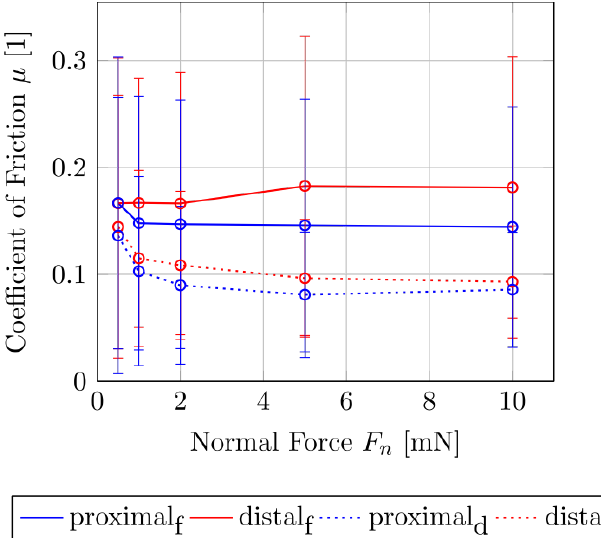
Figure 3. Coefficient of friction for different normal loads calculated from friction force measurements in the tibia–tarsus joint of P. marginata . Error bars show standard deviations of the means. Distal: in the distal sliding direction. Proximal: in the proximal sliding direction. Index f: fresh sample condition. Index d: dry sample condition.